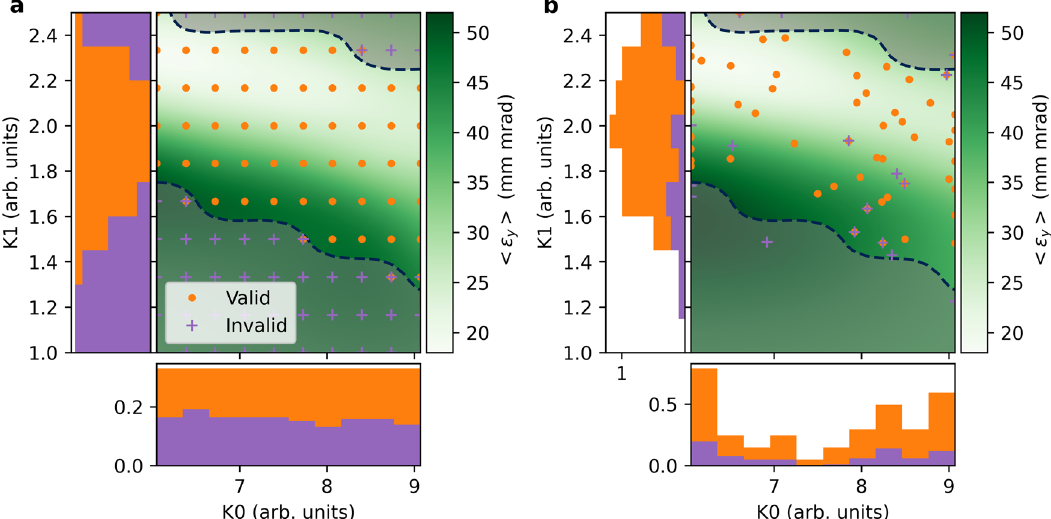
Fig. 3 Comparison between uniform grid sampling and CPBE. a A 10 × 10 grid is sampled over an operational subdomain identi fi ed by prior experimentation. Color mesh represents the posterior predicted mean of a Gaussian process trained on the valid measurements. Stacked histograms show sampling density of measurements along each axis. b 2D projected samples from Bayesian exploration after 66 iterations with 4 parameters (K0, K1, DQ4, DQ5). In both plots, shading with dashed line denotes invalid region in subdomain with 50% con fi dence, calculated from uniform grid sampling.